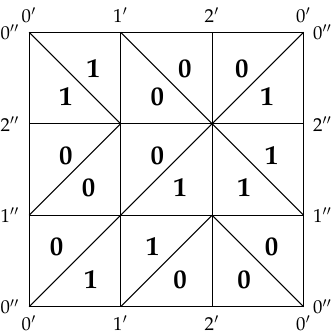
∂ ∆ 2 . Figure 1. An optimized covering of the ordered product ∂ ∆ 2 × ∂ ∆ 2 . × Relevant stages in the actual process performed by OptimizedCovering (Algorithm 5) that lead to the cover are illustrated in Figure 2. At each of the stages shown, the J 0 , J 1 { } largest (smallest) subcomplex is highlighted in light (dark) gray. OptimizedCover